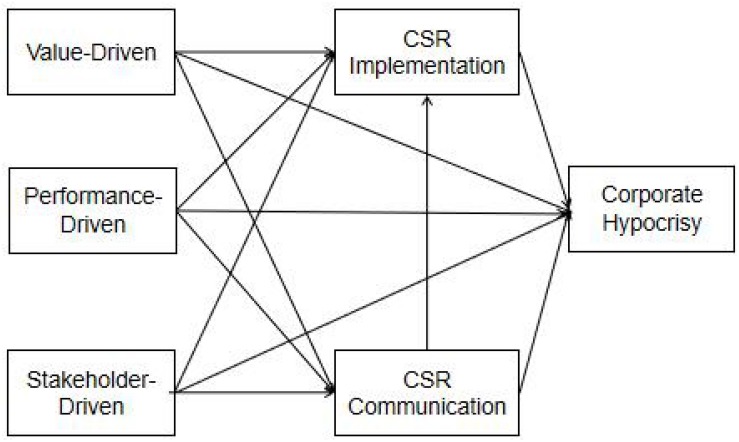
Research framework.